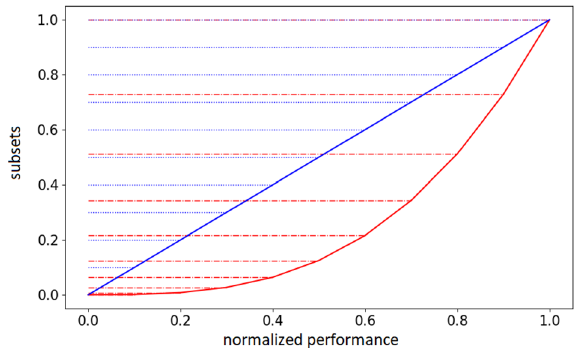
Figure 3. Difficulty intervals obtained by using a linear and a quadratic power difficulty function. Data shown in blue and red, respectively. The horizontal axes represent performance normalized in the range [0.0, 1.0], i.e. the fitness obtained by the last 5 agents normalized in the range [0.0, 1.0]. The vertical axes represents the intervals of the subsets, with η = 10. The intervals of the subsets in the case of the linear function are [0.0, 0.1, 0.2, 0.3, 0.4, 0.5, 0.6, 0.7, 0.8, 0.9, 1.0]. The intervals in the case of the quadratic power function are [0.0, 0.01, 0.04, 0.09, 0.16, 0.25, 0.36, 0.49, 0.64, 0.81,